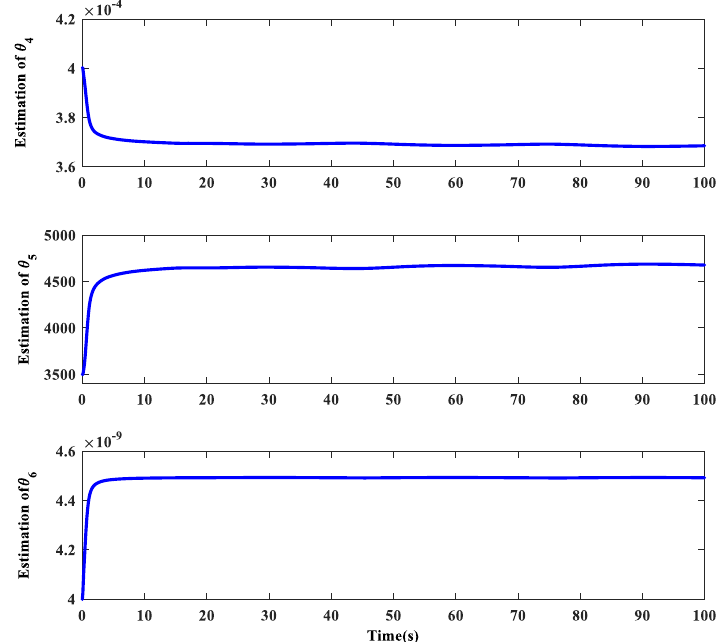
Figure 12. The parameter estimations of θ 4 ~ θ 6 with the ADRAC.